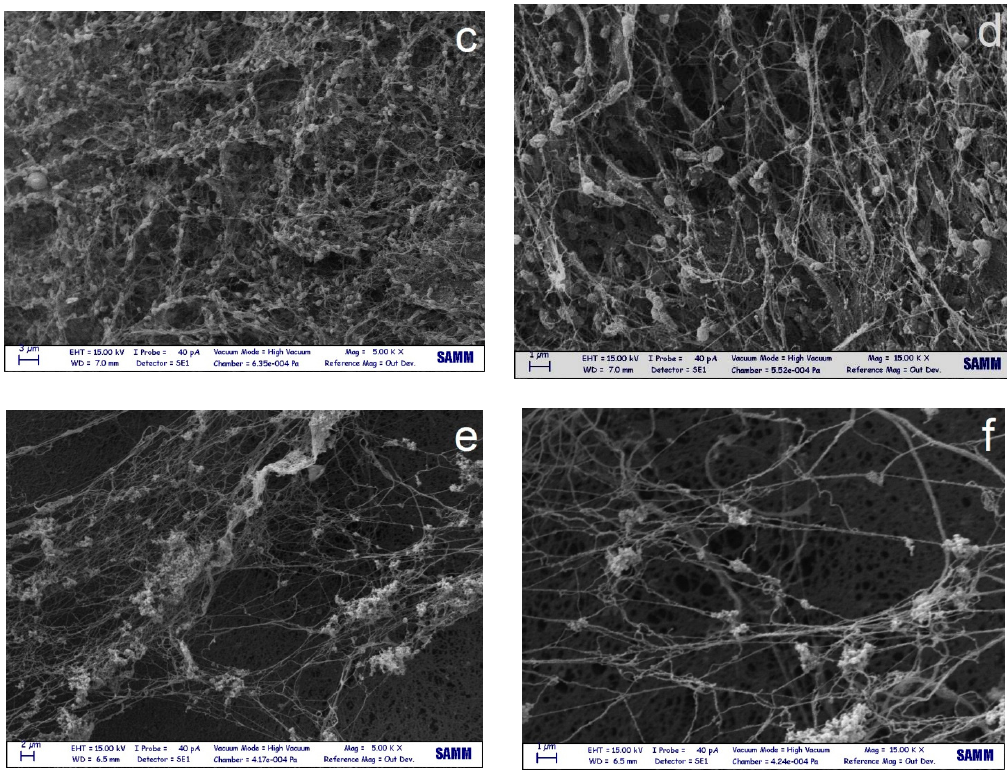
Figure 15. Scanning electron microscopy (SEM) micrographs of bacterial nanocellulose: ( a , b ) BNC as it is; ( c , d ) BNC-GMA (0.64 MS); ( e , f ) BNC-GMA-EGDMA (0.55 MS).